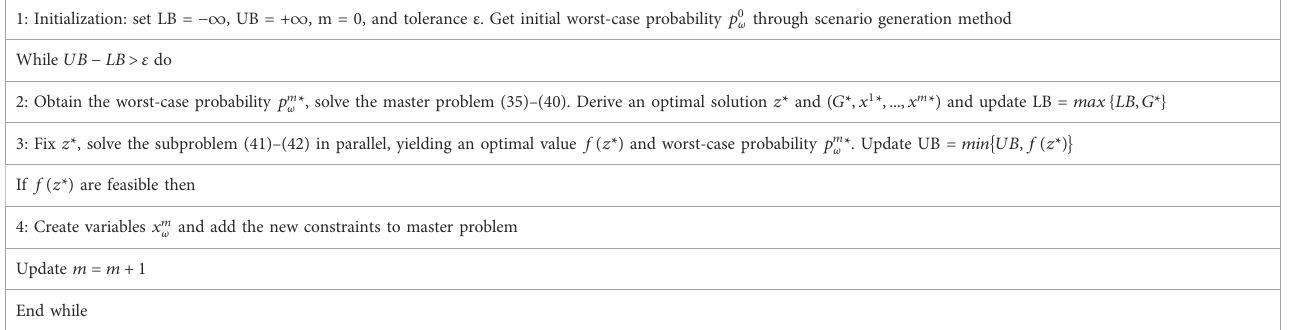
TABLE 1 PROCEDURE of modi fi ed C&CG ALGORITHM. Algorithm 1 modi fi ed C&CG algorithm